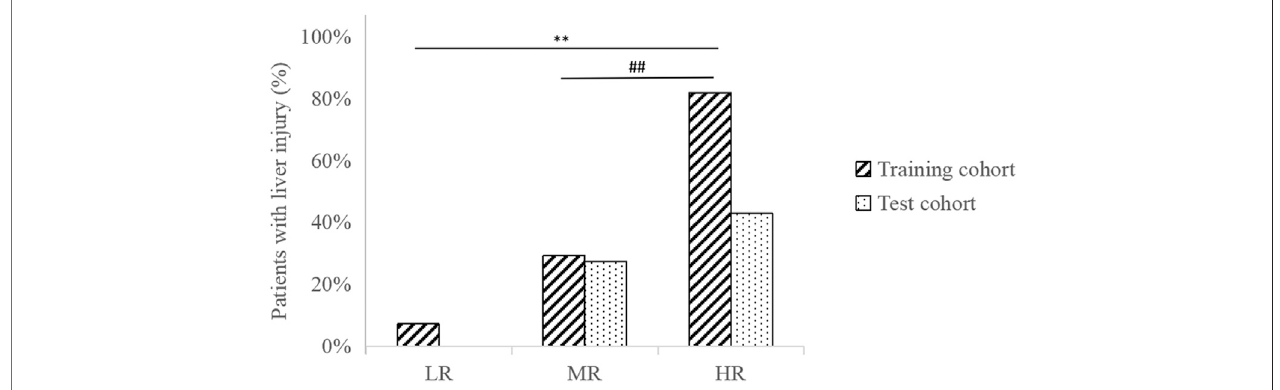
FIGURE4| Distributionofpatientswithliverinjuryamongdifferentriskgroupsintrainingandtestcohorts.** p < 0.01,indicatingsigni fi cantdifferencesbetweenLR- HR groups in the training cohort. ## p < 0.01, indicating signi fi cant differences between MR-HR groups in the training cohort.